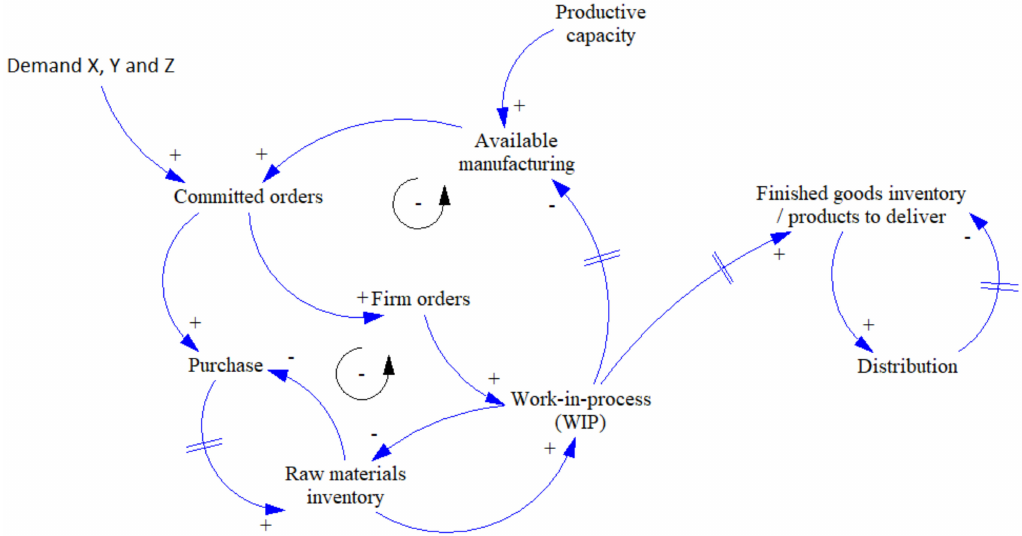
Figure 4. Influence diagram. Source: own elaboration. Designed in Vensim software. The diagram shows the variables connected by arrows representing the relationship between them. The direction of these arrows corresponds to the direction of the effect. The “+” or “ − ” signs are the signs of the effect, where “+” indicates that the variables change in the same direction while “ − ” indicates the